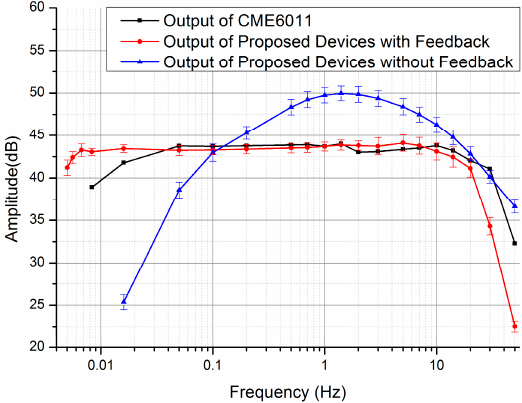
Figure 6. Frequency characterization results of the MEMS electrochemical seismic sensor with and without feedback (n device = 6) in comparison to CME 6011. The amplitude is the output voltage of the electrochemical seismic sensors at the same input velocity and different frequencies.